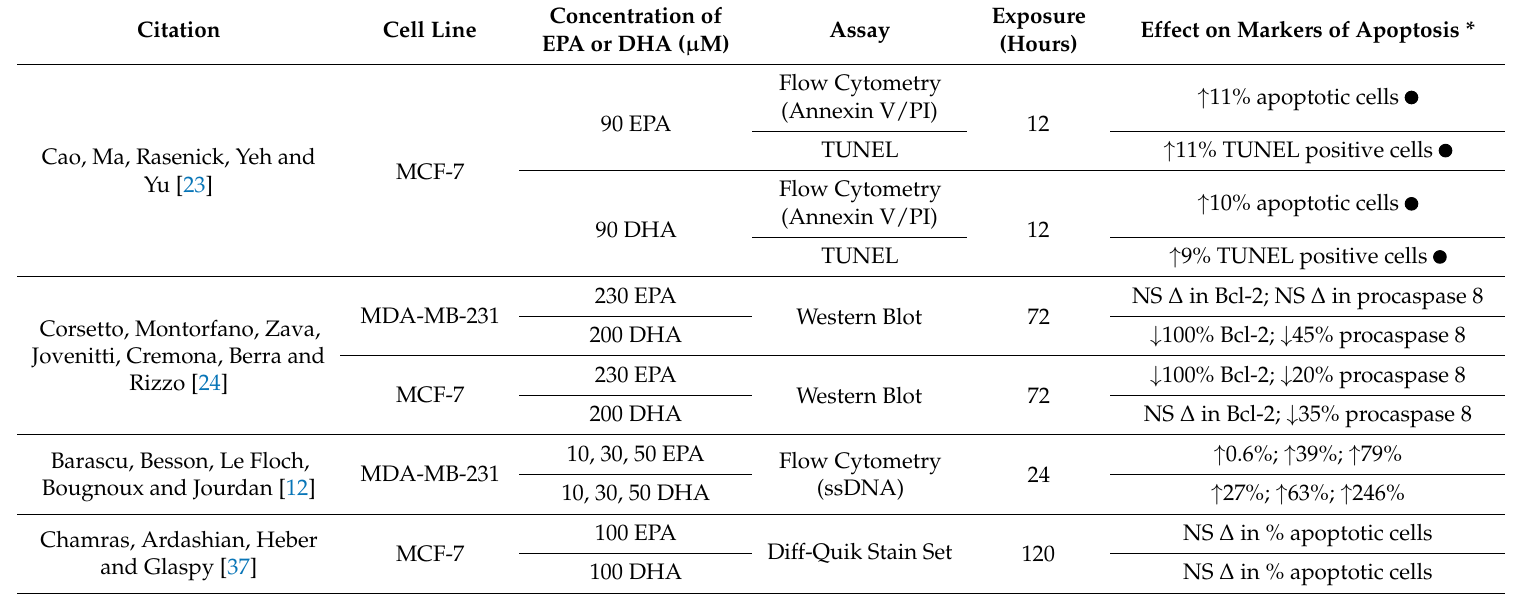
Table 10. Comparison of EPA and DHA on changes in apoptotic markers in human BC